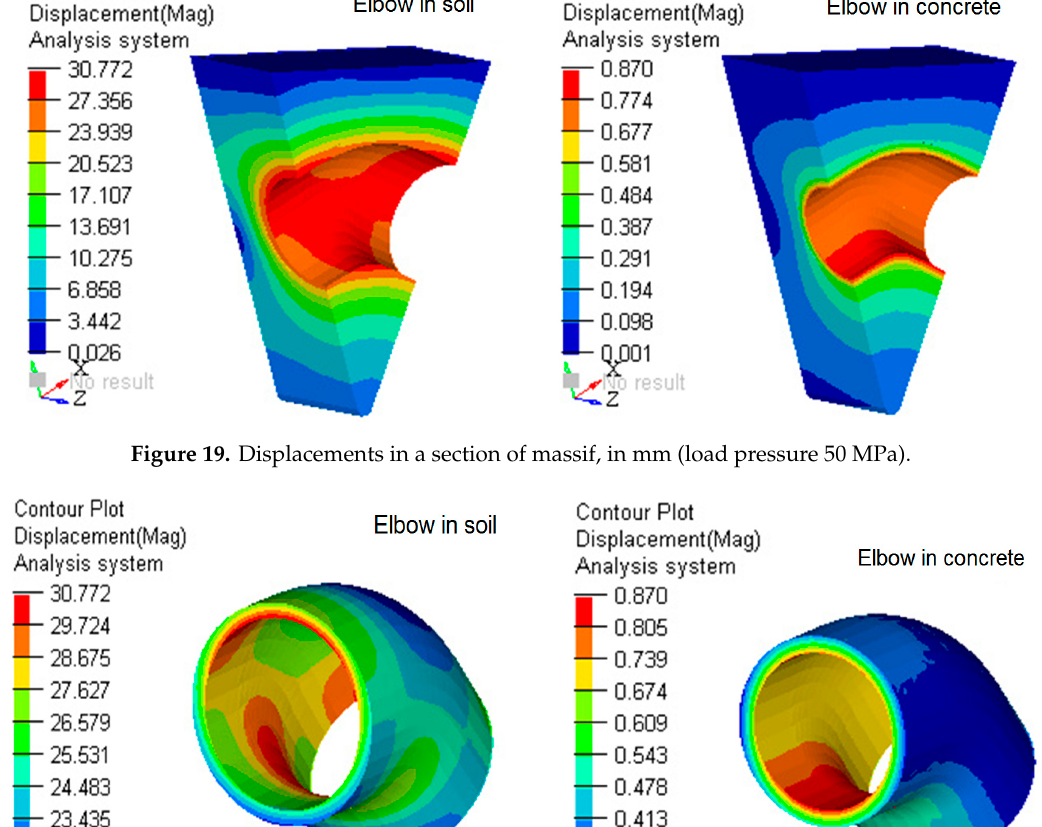
Figure 18. Structural model of the elbow buried in the soil.